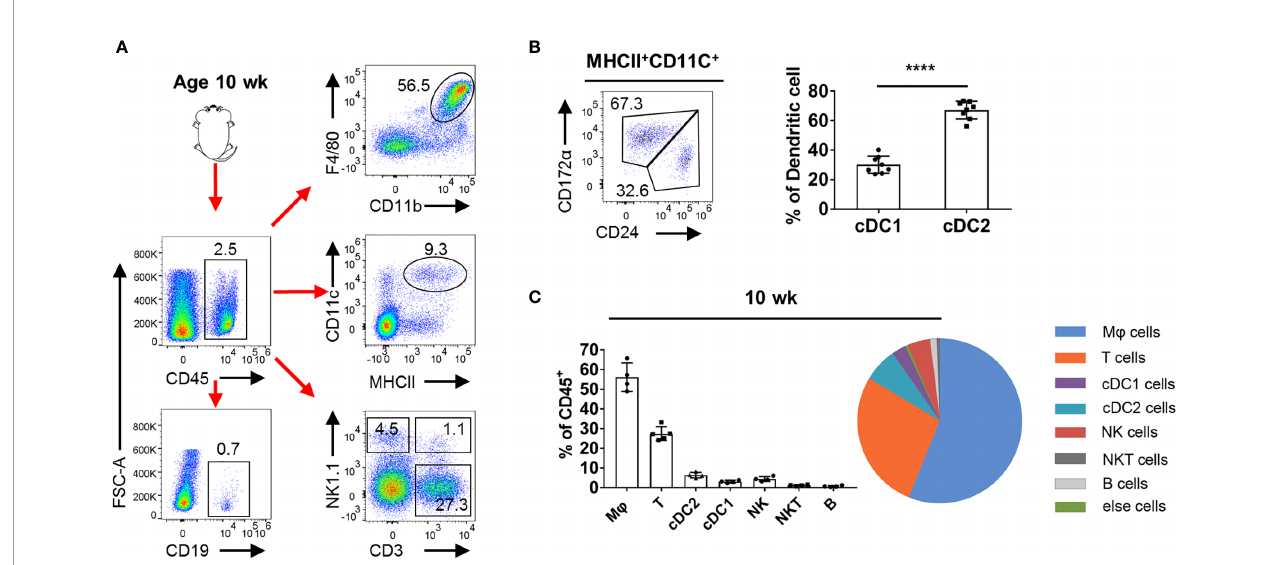
FIGURE 1 | FACS analysis of the immune cells in adult mouse testis. (A) Representative FACS plots showing the gating strategies for CD45 + cell, M j (CD11b + F4/80 + ), DC (CD11c + MHCII + ), T cells (CD3 + NK1.1 − ), NK cells (NK1.1 + CD3 − ), NKT cells (CD3 + NK1.1 + ), and B cells (CD19 + ) from the testis (pre-gated on single cell/live cell). (B) FACS analysis of the frequency of cDC1 (CD24 + CD172 a − ) and cDC2 (CD172 a + CD24 − ) in total DC in the testis of C57BL/6 mice. n = 8. Data were pooled from two experiments. (C) Summary graphs and pie chart illustrate the percentage of M j cells, T cells, cDC1 cells, cDC2 cells, NK cells, NKT cells, and B cells in CD45 + cell from the testis of 10-week-old mice. Error bars are the mean ± SD. (B) One-way ANOVA with Tukey ’ s multiple comparisons test was performed. ****P <